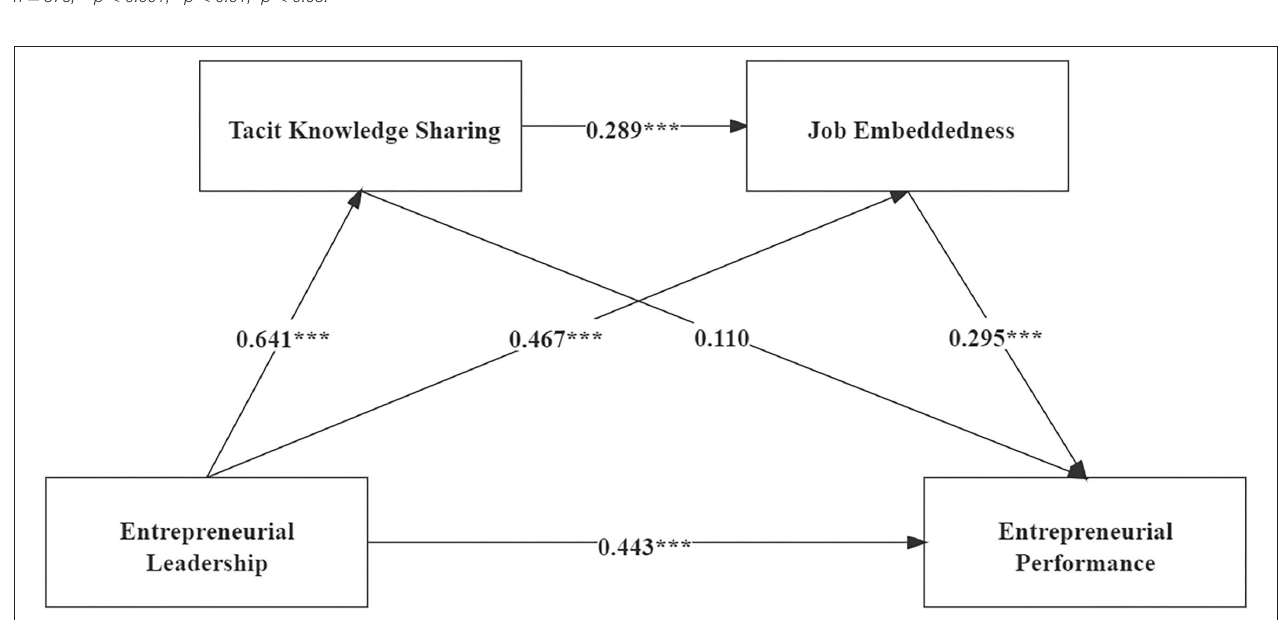
FIGURE 2 | Main effects. n = 376; *** p < 0.001.